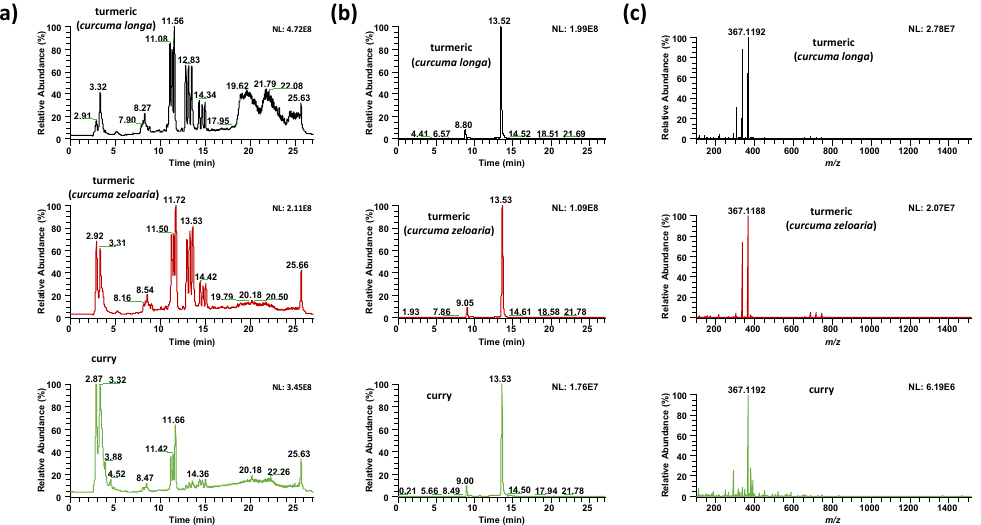
Figure 2. ( a ) Ultra high-performance liquid chromatography-high resolution mass spectrometry (UHPLC-HRMS) total ion chromatogram (negative ionization mode), ( b ) UHPLC-HRMS extracted ion chromatogram for curcumin (accurate mass at m / z 367.1187), and ( c ) HRMS spectrum at RT 13.53 (corresponding to elution of curcumin) for a Curcuma longa turmeric sample (Biospirit brand), a Curcuma zedoaria turmeric sample (Dani brand), and a curry sample (Hacendado brand).